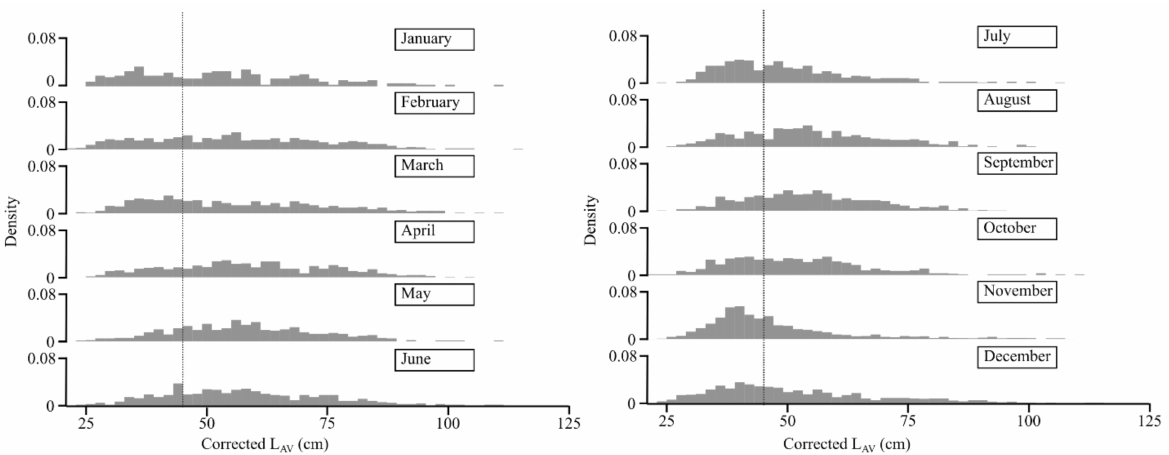
Figure 4. Monthly size (corrected L AV ) frequency distribution of eels swimming toward the lagoon. The black line represents the corrected L AV of 45 cm above which eels are considered as